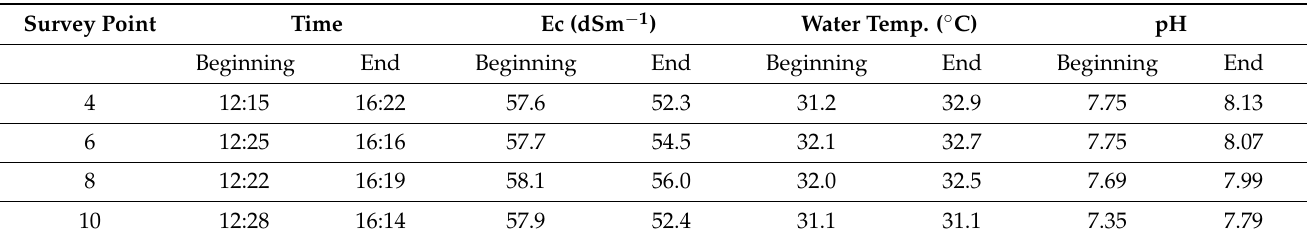
Table 3. The beginning and the end values of EC, water temperature and pH measured in a creek water on Moucha Island, Djibouti (12 September